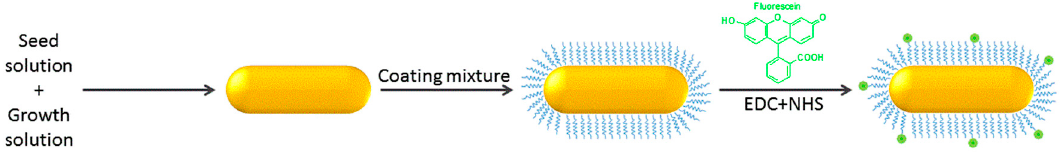
Figure 9. A schematic representation of the linkers’ end-to-end length in scale relatively to each other.